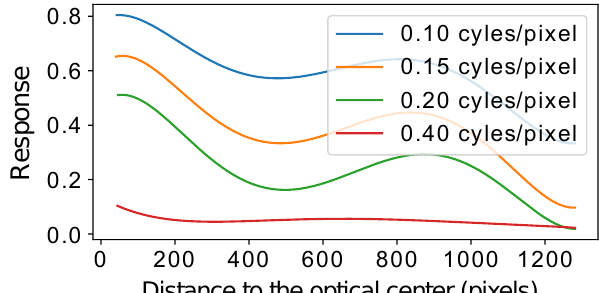
Figure 8. This figure shows the MTF testing results for Lens 0 (Lensagon). A large cycle or pixel number indicates a large spatial frequency. It can be seen that the responses for an identical frequency were diverse in different sensor areas. The responses of the central pixels were higher than those of the border pixels.